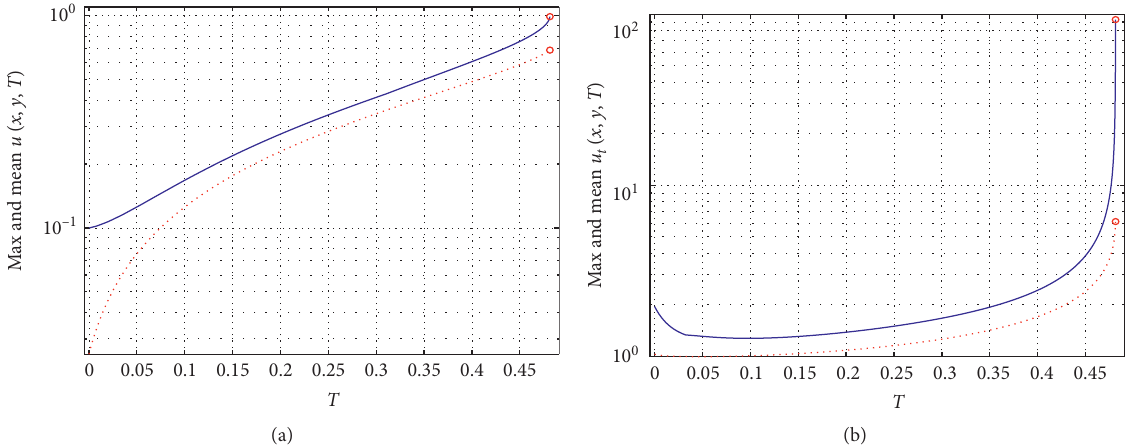
Figure 6: Trajectories of the maximal (blue curves), mean values (red dotted curves) of u ( x,y, T ) , 0 ≤ x, y ≤ 1, (a); and the maximal (blue curves), mean values (red dotted curves) of u t ( x,y, T ) , 0 ≤ x,y ≤ 1, (b) for T ∈ ( 0 , 0 . 48140837 ] . They are similar to those in Figure 3. Explosive increments of the derivative function values as t approaches the quenching time 70483 τ ≈ 0 . 48140837 < T ∗ ≈ 70485 τ ≈ 0 . 48142203 are again visible. The phenomena agree with (6) and (7) satisfactorily.